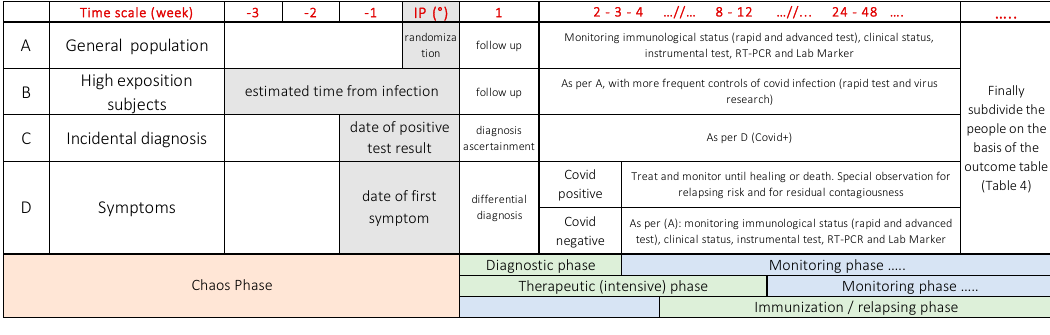
Figure 3. The timeline representing the different phases of the diseases. The interpretation of the results of the rapid tests depends on where the patients are in the timeline. The different groups are classified according to anamnestic criteria. The inception point varies fittingly. Each group represents different settings, where the rapid test can be used for different purposes: ( A ) Screening of a whole population for epidemiological reasons; ( B ) screening of a high-risk population; ( C ) screening in close contacts for diagnosis, follow-up and case tracking; ( D ) diagnosis and follow-up in symptomatic patients. In all case scenarios, the rapid test can provide information related to the possible acquired immunity to coronavirus. Finally, people and patients in each group should be divided according to the different outcomes shown in Table 4.